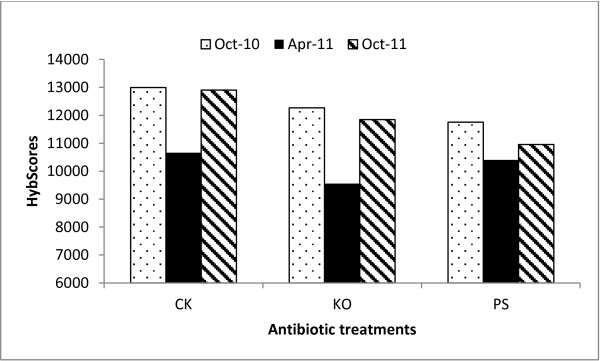
PhylochipTM HybScores of ‘Candidatus Liberibacter asiaticus’ (Las) from Huanglongbing (HLB)-affected citrus. The citrus plants were treated with antibiotic combinations and sampled at different times (October 2010, April 2011 and October 2011) over a year. (i) Severe HLB-like symptoms with Ct values <26, and Las bacterial titers of more than 770,000 cells per gram plant tissue; (ii) no symptoms with Ct values ≥36.0, and Las bacterial titers of less than 1,060 cells per gram plant tissue. A HybScore change of 1000 indicated a doubling in the fluorescence intensity of the OTU. PS: 5 g/tree penicillin G potassium and 0.5 g/tree streptomycin; KO: 2 g/tree oxytetracycline and 1.0 g/tree kasugamycin; and CK: water as control.